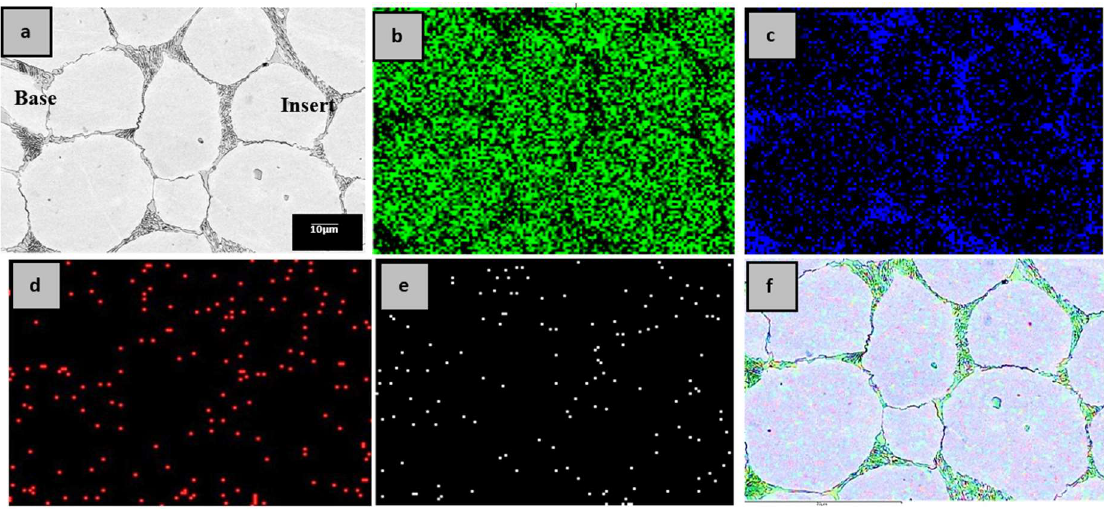
Figure 10. SEM-EDX elemental mapping of thixojoined part at 1300 °C of results near joint: ( a ) SEM micrograph, ( b ) Fe, ( c ) Cr, ( d ) C, ( e ) V, ( f ) all four elements.